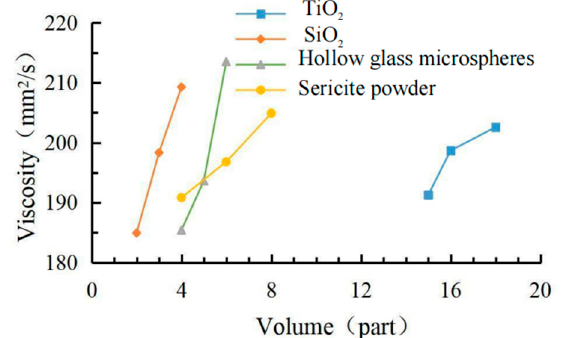
4 Table 6. Orthogonal test results of packing. Test Number